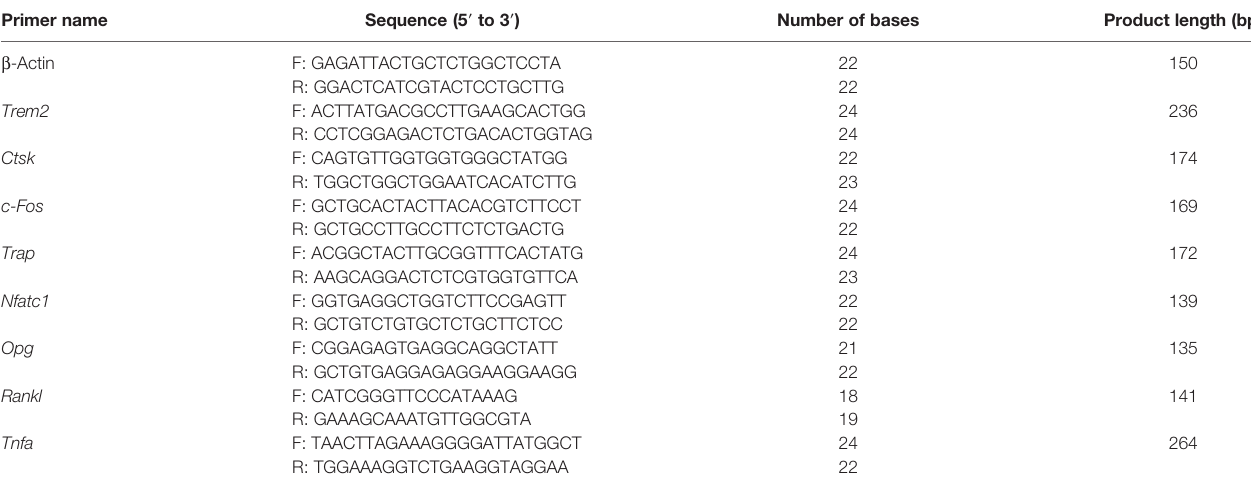
TABLE 1 | Primers used in our